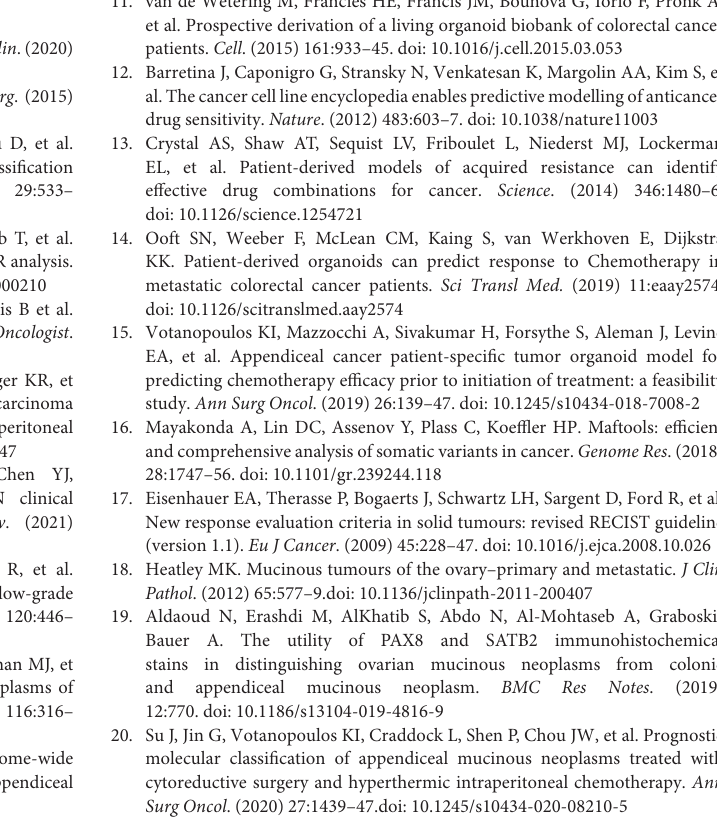
Supplementary Figure S1 | (A) Overview of the design of this study. (B) Statistical analysis of immunohistochemical staining intensity of CDX-2, CK20, STAB2, PAX-8, and CK7 in organoid (passage 8) and tissue. Supplementary Figure S2 | Circos plots of the original tissue and cancer